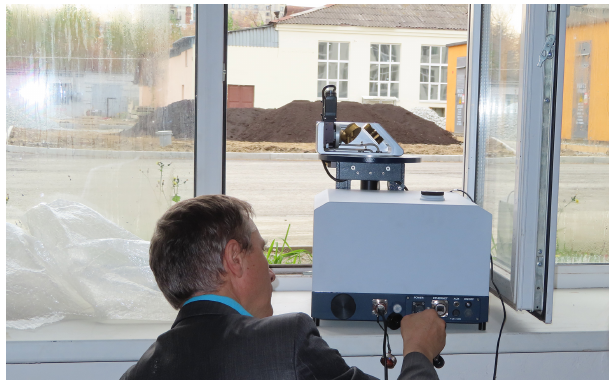
Figure 6. Instrument set-up at Yekaterinburg. The time interval of the daily measurements was constrained by the building structure, which blocked the